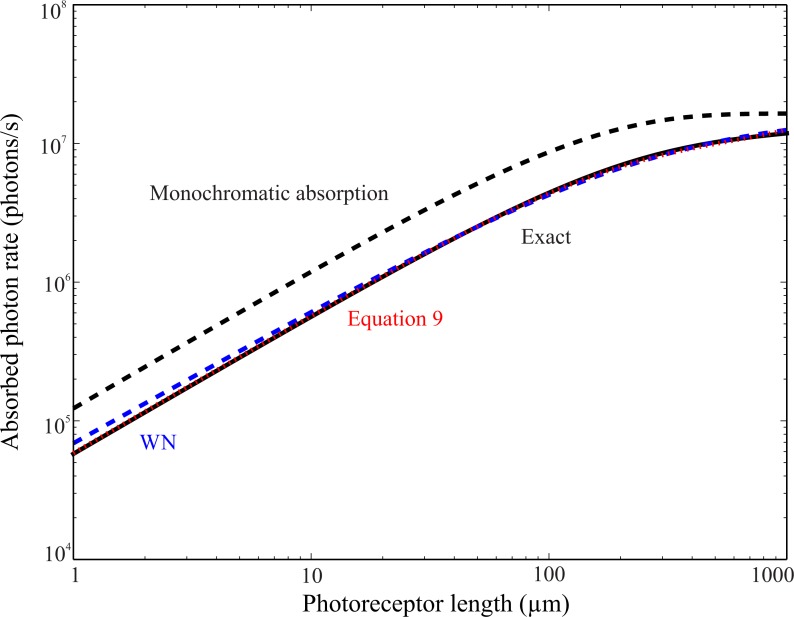
Absorption of blue skylight by UV rhodopsin, NiFa(κ), as a function of length lr.The exact calculation (black solid line) is very different from exponential absorption at the peak wavelength (black dashed line). Our approximation to Fa(κ), (Eq. (9), red dotted line), fits better at very short lengths than approximation made by Warrant & Nilsson (1998) (blue dashed line). Parameters used for calculations as in subscript to Fig. 2.